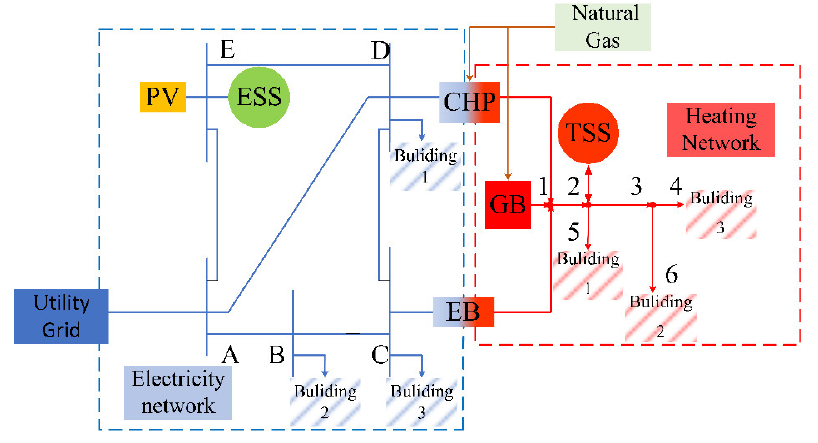
Figure 4. The IES network structure.